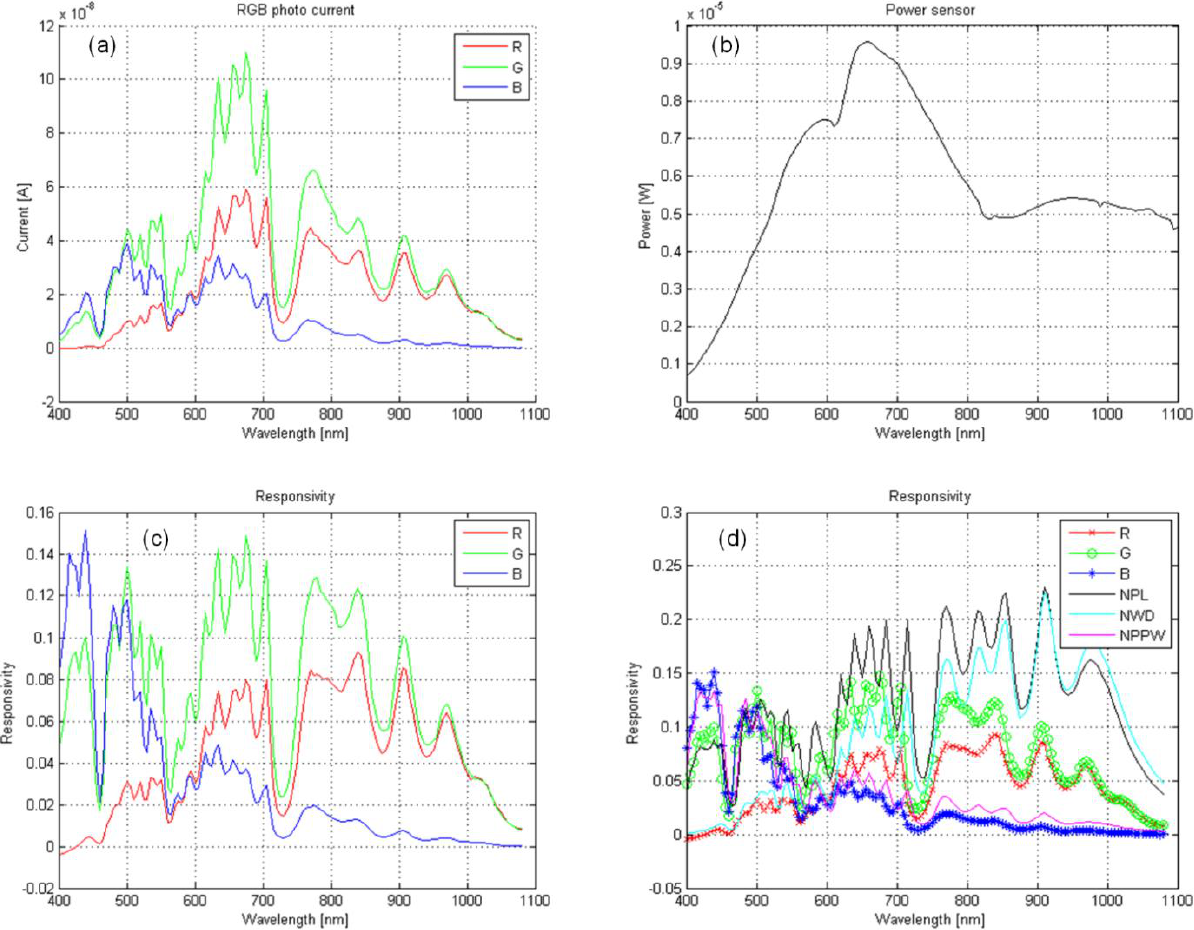
Figure 19 . ( a ) Measured photocurrents of different photo-diodes; ( b ) Power of the light on the sensor as a function of the wavelength; ( c ) Responsivity of the complete detection system for three different photo-diodes; ( d ) A responsivity comparison between the integrated color detection system of this article and measurements obtained with the optical lab